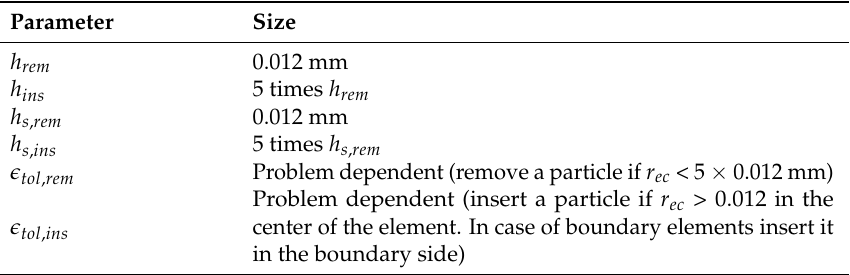
Table 2. Mesh parameters used in the numerical